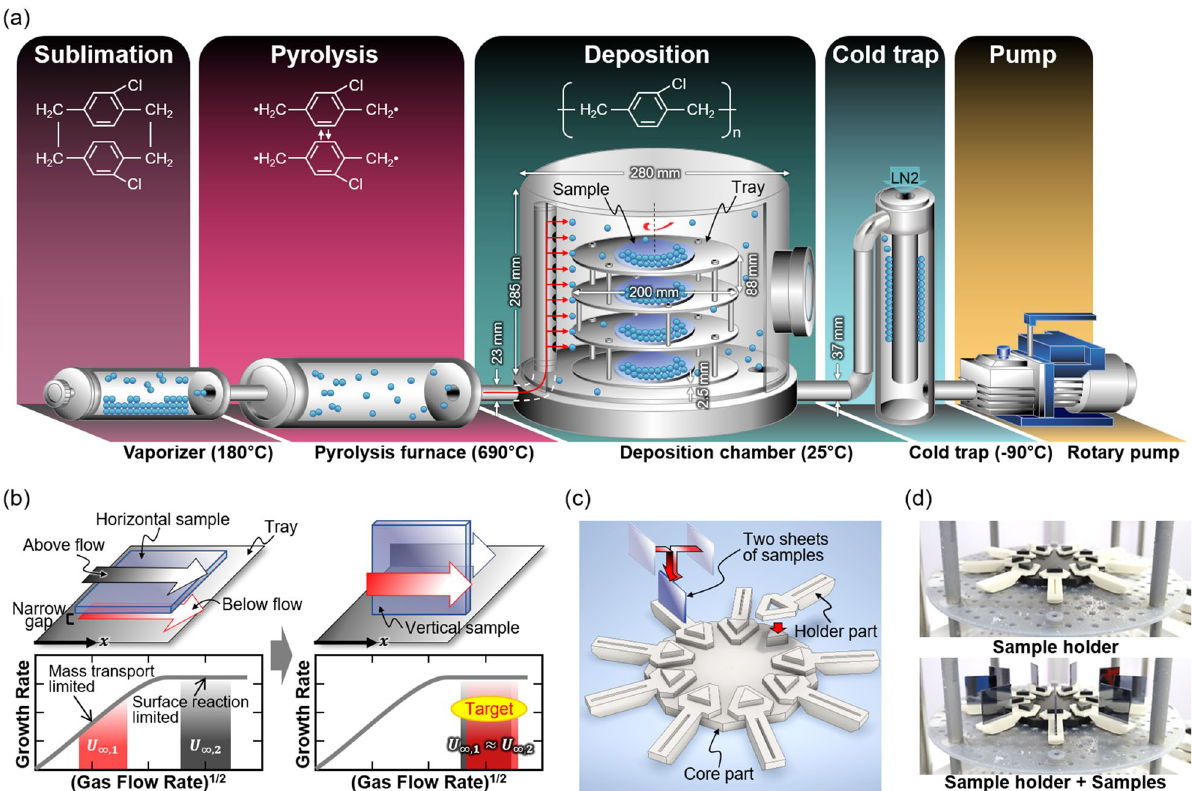
Figure 1. Schematic diagrams of ( a ) the conventional deposition setup for parylene C films and ( b ) the expected parylene C monomer vapor flow in the sample with horizontal and vertical deposition. ( c ) Sample holder layout designed for vertical deposition and ( d ) actual photos of parylene C coating system